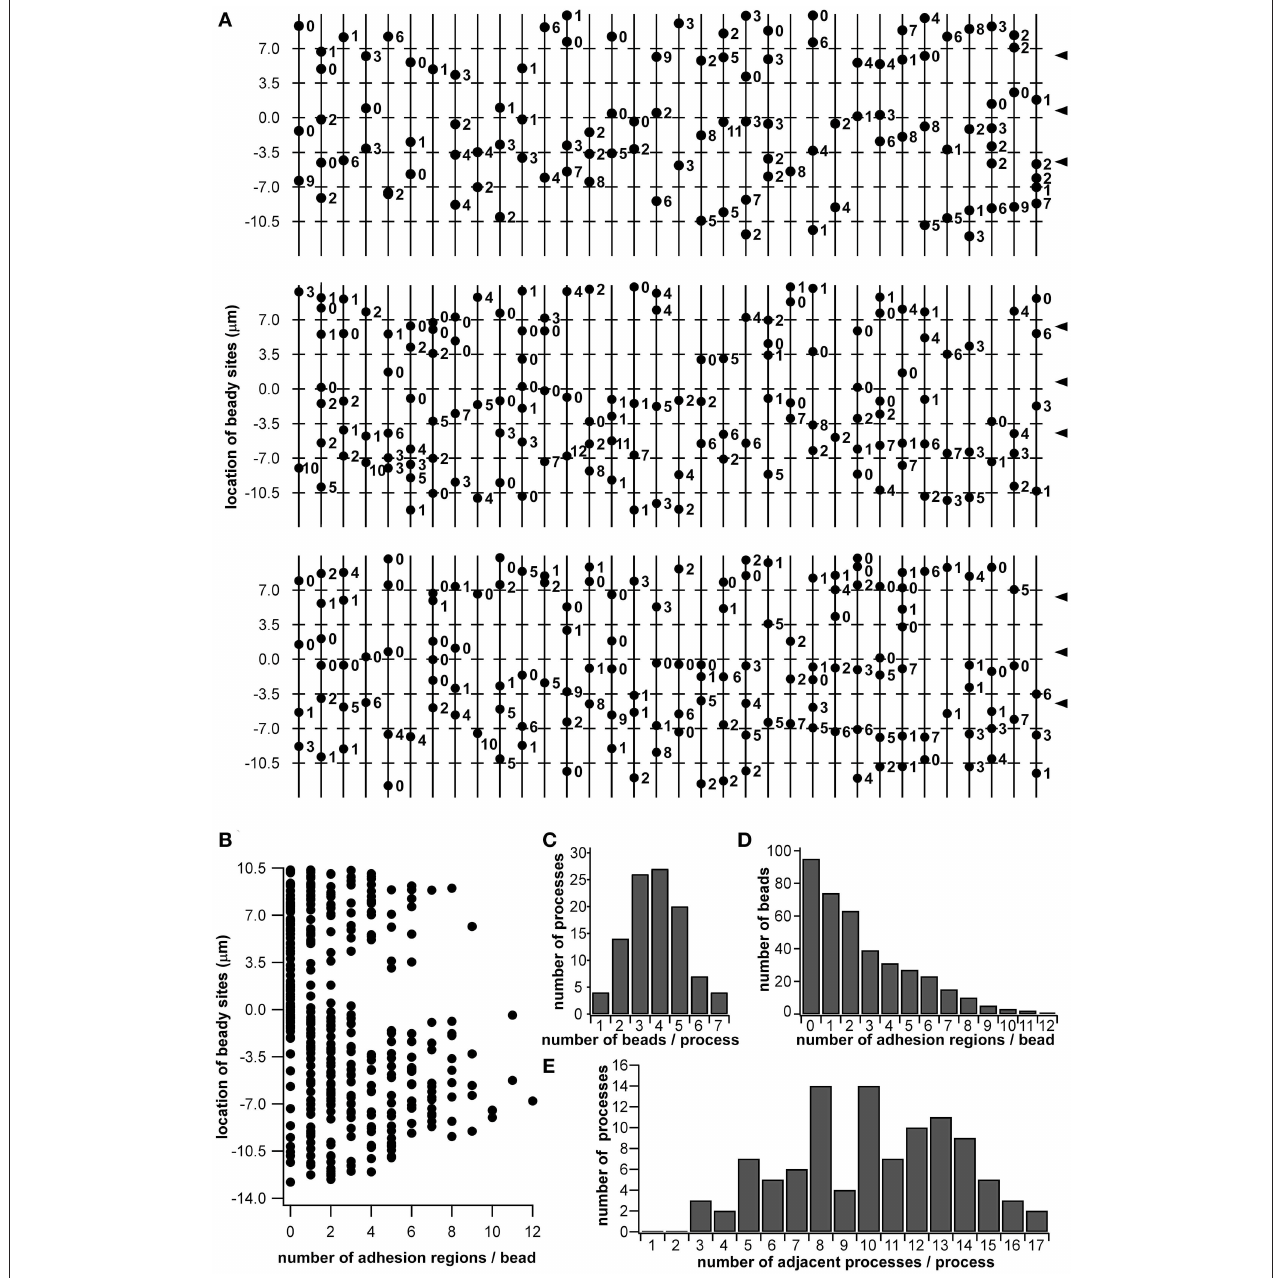
FIGURE 6 | Schematic diagram of beaded-structures in the dendritic processes of ORNs and the bead distribution within a Sensilla basiconica . Based on the SBF-SEM images in Figure 1 , beady sites and putative GJ regions on them were counted by hands. (A) Schematic image of beaded-structures on all of 102 dendritic processes of the ORNs within an s. basiconica . (B) Distribution of beady sites along the dendritic processes with the number of adhesion regions as putative GJs at every bead. (C) Distribution of the dendritic processes in the number of beads per process. (D) Distribution of the beads in the number of adhesion regions per bead. (E) Distribution of the dendritic processes in the number of adjacent processes per process.